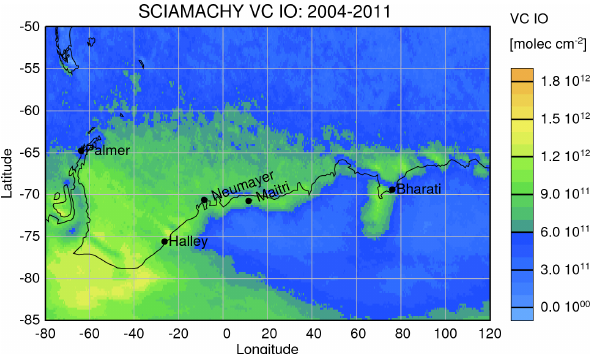
Figure 9. Averaged VCDs of IO retrieved by SCIAMACHY be- tween 2004 and 2011 are shown. Observations suggest that lower levels of IO are expected at Bharati and Maitri compared to Halley Bay and